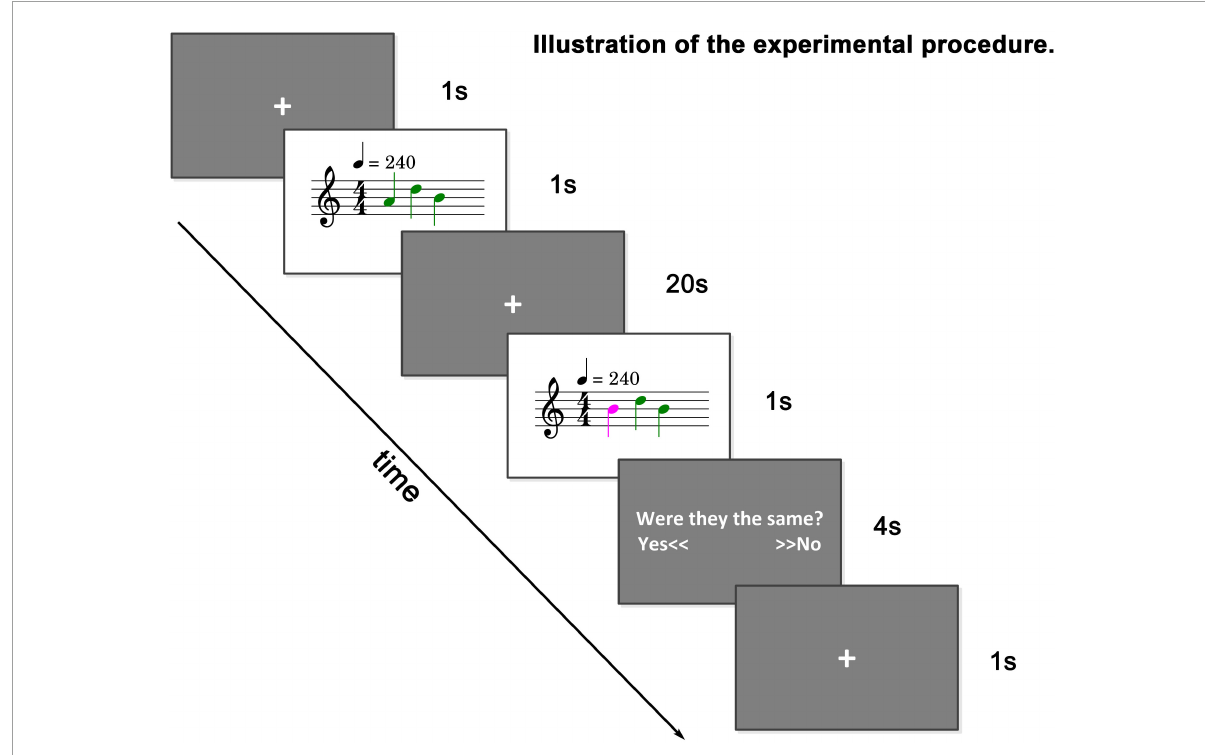
FIGURE5 Illustration of sample dataset. A string of tones (0–4 tones) is played. After 20 s, another string of tones is played. The number of tones is equal. There is a 50% probability that one tone is different. Subjects were asked to judge whether the two strings of tones were the same.